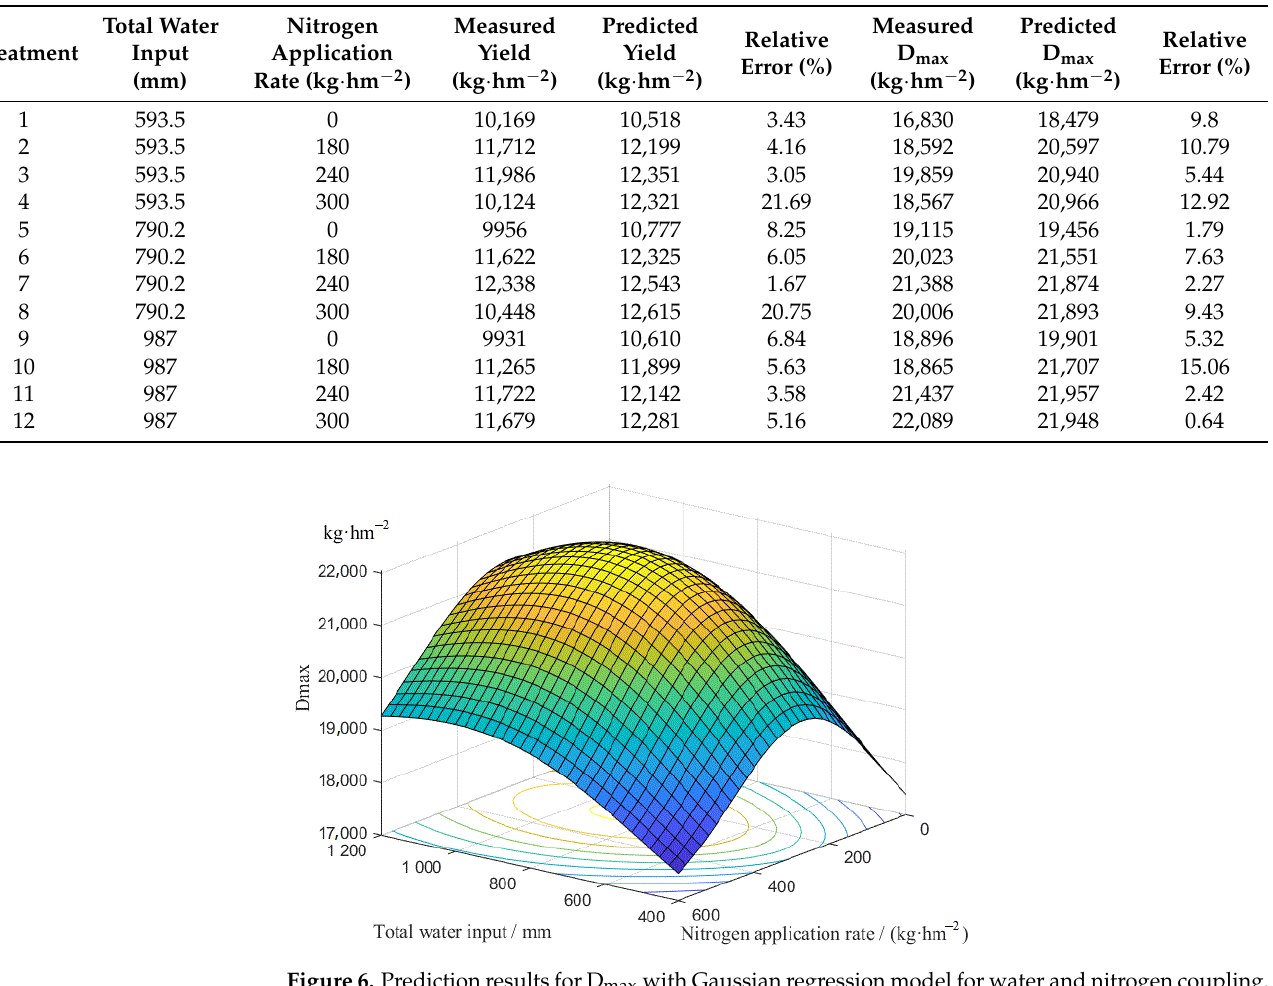
Figure 5. Regression models for maximum dry material mass for summer maize. Table 3. The measured and predicted values of yields and D max .